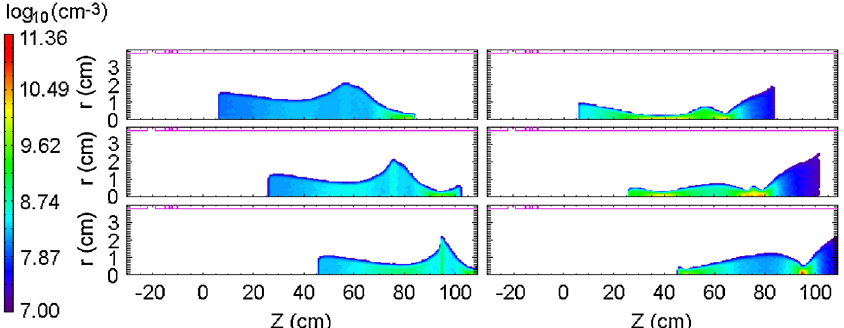
FIG. 21. (Color) f r; z g isocontour plots of beam density n t (cid:6) 1320 ns (bottom row) for the regular transverse focusing (cid:2) (cid:3) (cid:1) 32 : 3 mrad case (right column). All plots are on the same log